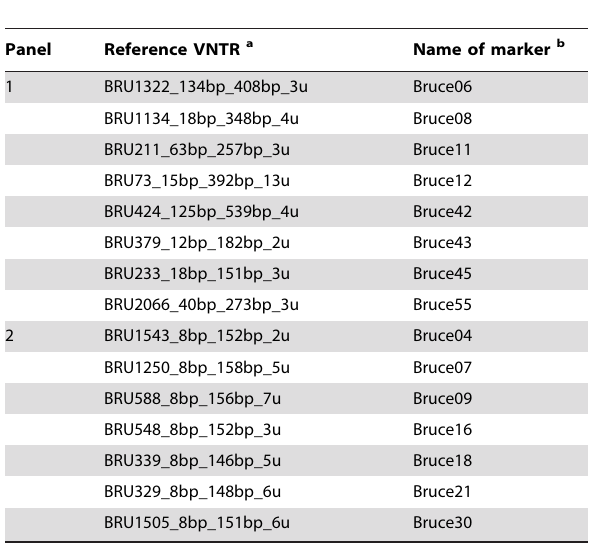
Table 2. Loci of the Variable Number Tandem Repeats analysis (VNTR) used in the study (according to